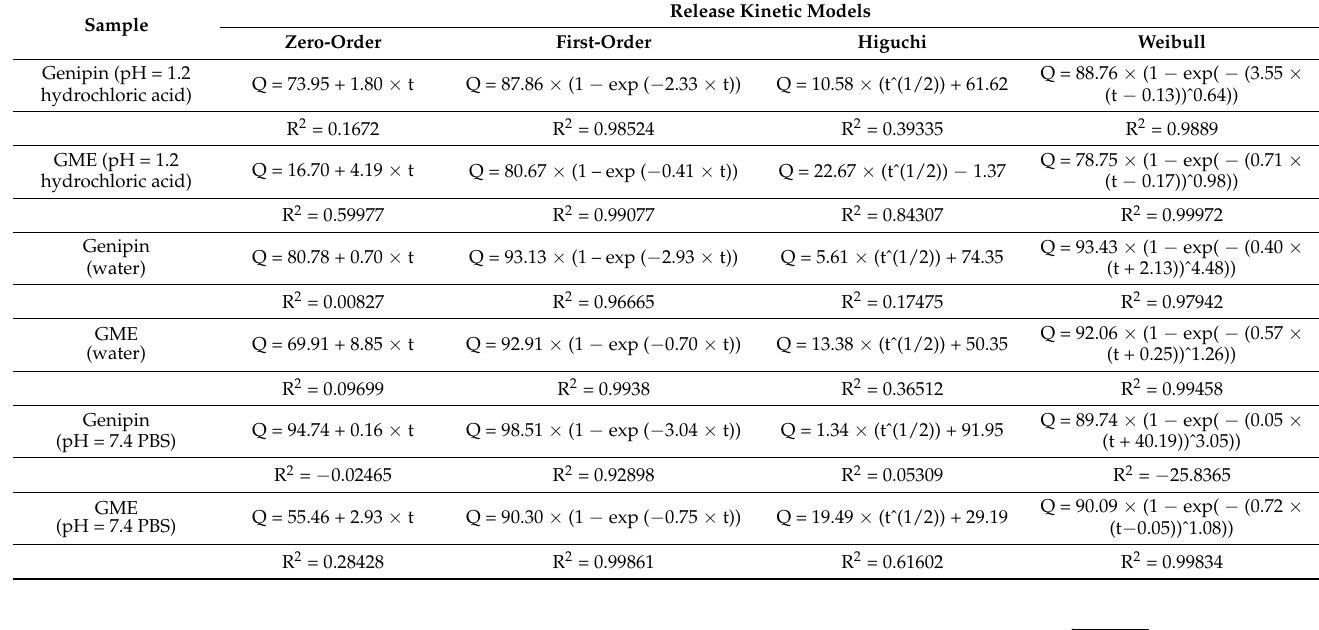
Table 3. The equations and correlation coefficients (R 2 ) of different release models.